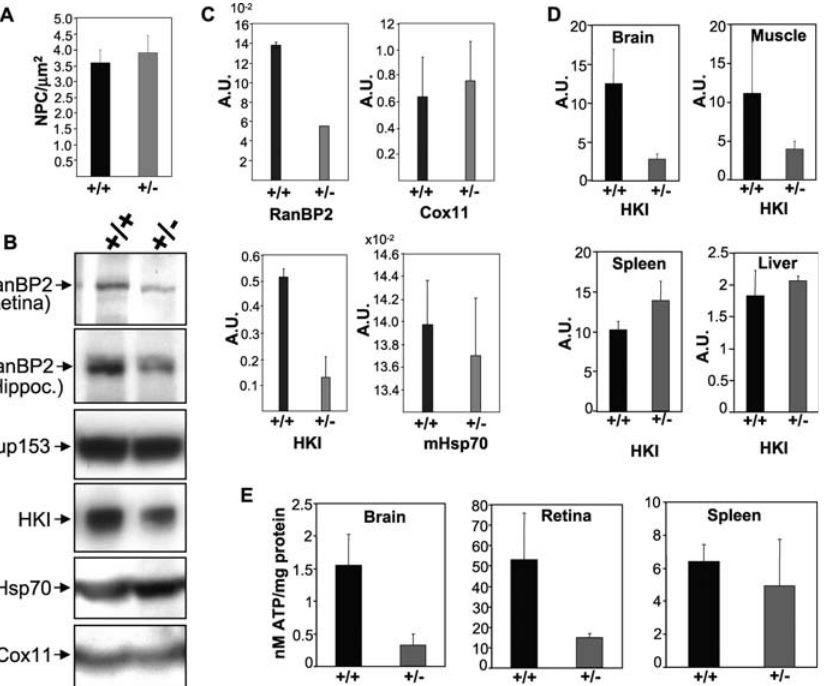
Figure 5. Haploinsufficiency of RanBP2 Causes a Decrease in HKI Protein and ATP Levels (A) Quantitative analysis of NPCs in dissociated hippocampal neurons of wild-type ( þ / þ ) and heterozygote ( þ / (cid:1) ) mice upon immunostaining with mAb414. No difference in the density of NPCs (3–4 NPC/ l m 2 ) at the nuclear envelope was found between RanBP2 þ / þ and RanBP2 þ / (cid:1) mice. (B) Immunoblots with anti-RanBP2/Nup153/Nup62 (mAb414), (cid:1) HKI, (cid:1) mHsp70, and (cid:1) Cox11 antibodies of retinal (top panel) and hippocampal homogenates of þ / þ and þ / (cid:1) mice. In comparison to RanBP2 þ / þ , RanBP2 þ / (cid:1) mice exhibit a reduction in the expression levels of RanBP2 and HKI but not of other proteins. (C) Quantitative analysis of relative protein expression levels of RanBP2, Cox11, HKI, and mHsp70 in the hippocampus of RanBP2 þ / þ and RanBP2 þ / (cid:1) mice. There is ; 2- and 4-fold reduction of RanBP2 and HKI in heterozygote mice. (D) The level of HKI is reduced in the brain but not in other non-neuronal tissues tested (muscle, spleen, and liver). (E) The total ATP level is reduced in the CNS tissues (brain and retina) but not in non-neuronal tissues tested (e.g.,